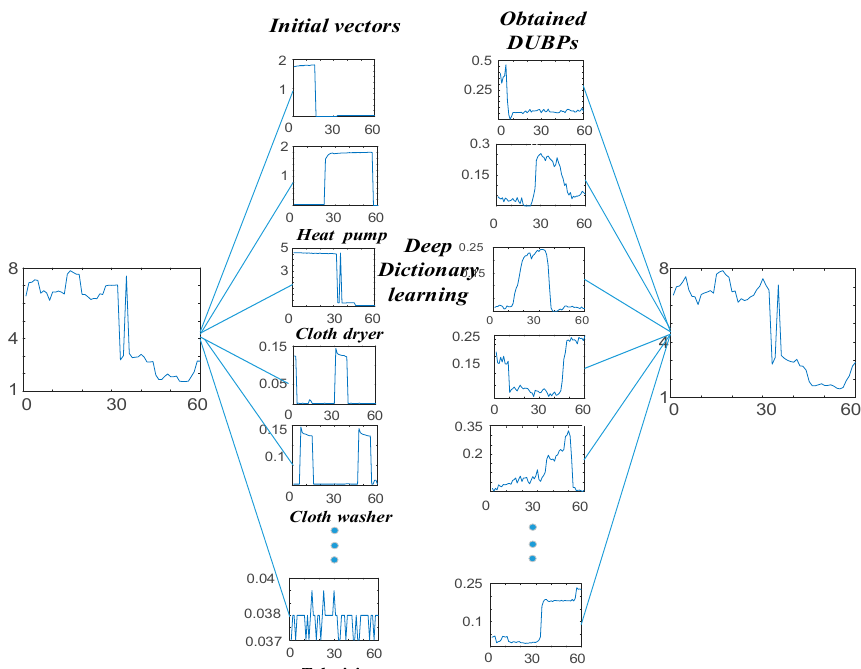
Figure 3. Deep non-negative K-SVD algorithms with an appliance load.